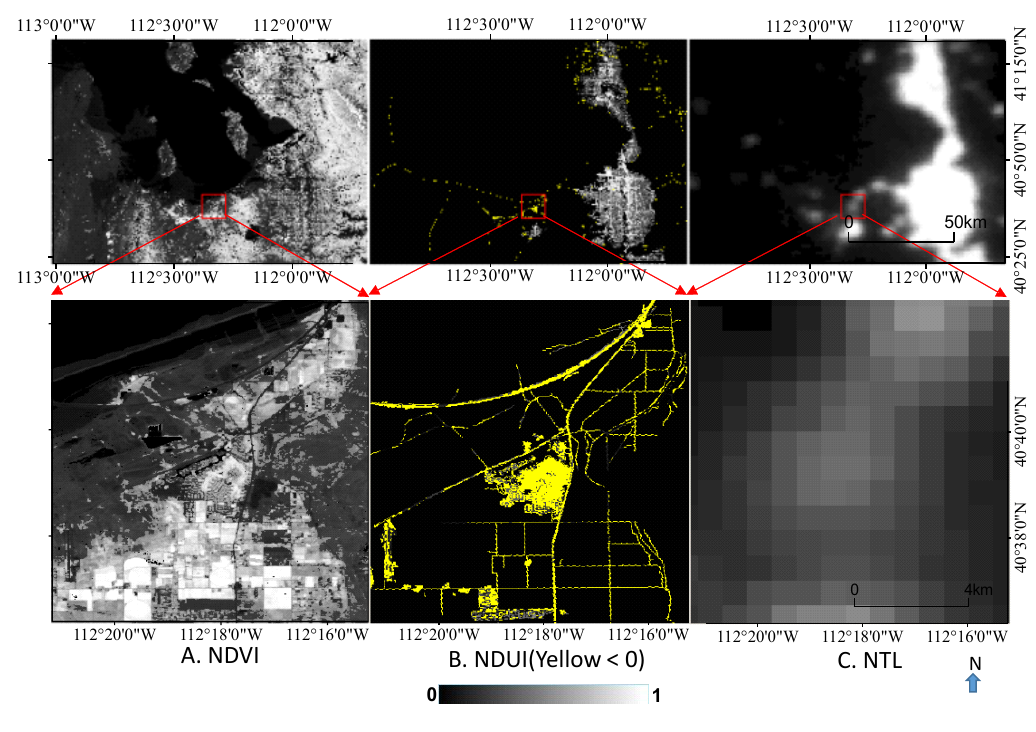
Figure 14. Some not-well-lit Developed areas cannot be well captured in the 2006 NDUI in the Salt Lake City